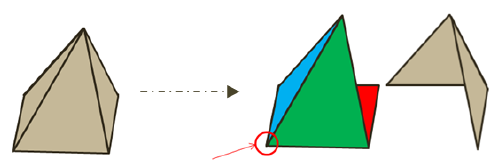
Figure 3: Intersection between bottom plane and top planes The bottom plane only has height (z direction) without any value in x and y direction. Accordingly, for computing the bottom plane coefficients, minimum height of upper plane is found. Then the intersection between planes is calculated by Eqs. (19) and (20).